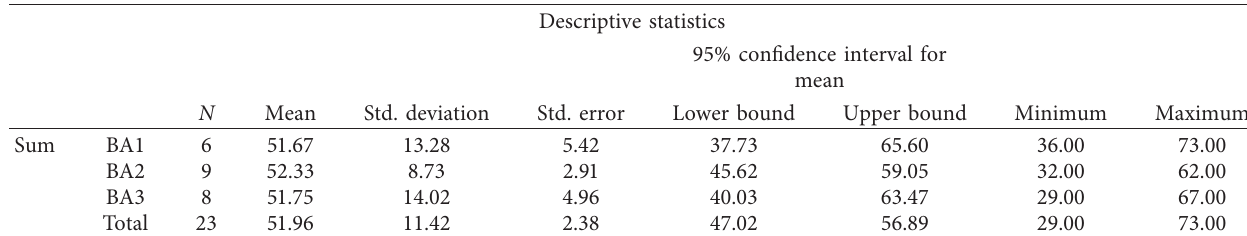
Table 6: Descriptive statistics of the sample.